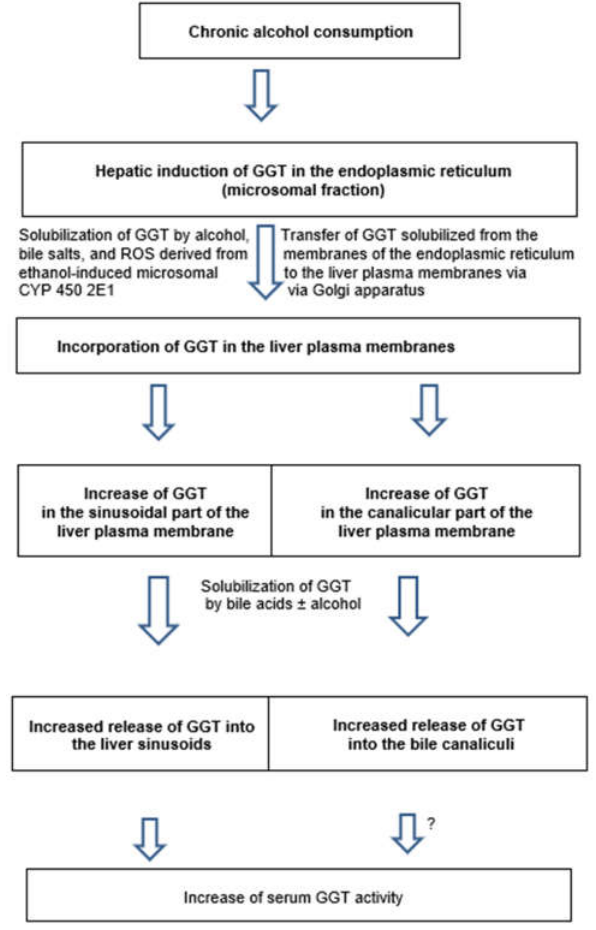
Figure 12. Hypothesis of events, leading to increased serum gamma-glutamyltransferase (GGT) activities, following chronic alcohol consumption. Mechanisms leading to increased GGT in the serum following alcohol abuse include microsomal GGT induction and enzyme solubilization via ethanol and bile acids. Symbol: ?, process under discussion. Abbreviation: GGT, gamma‐glutamyltransferase. Chronic alcohol consumption causes induction of GGT and various other parameters in the endoplasmic reticulum of the hepatocyte [23], with clinical implications (Figure 13).